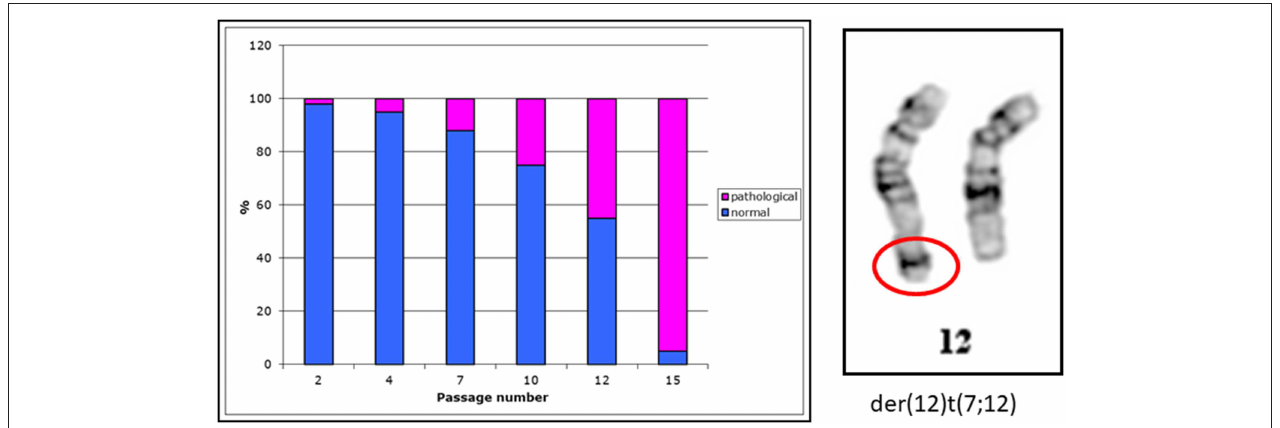
FIGURE 1 | Distribution of normal and pathological metaphases in the G-401 cell line. Metaphases of the G-401 cells. Percentage of normal (46, XY) and pathological (46,XY,der(12)t(7;12) metaphases in the G-401 cell line is shown in a diagram on a left side. With increasing passage number the numbers of metaphases having this derivative chromosome 12 (shown on a right side) were higher, n = 50 per